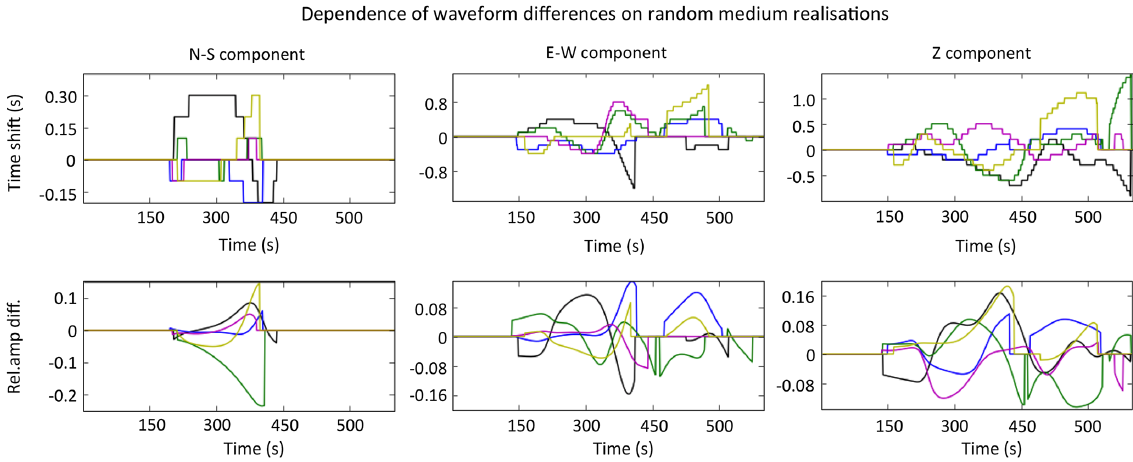
Figure 4. Component-wise time shifts and relative amplitude differences in the frequency band from 0 . 02 to 0 . 04Hz for five random media